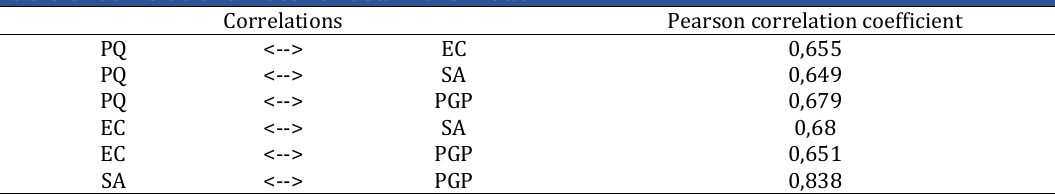
Table 6: Correlations materialised in the model Correlations Pearson correlation